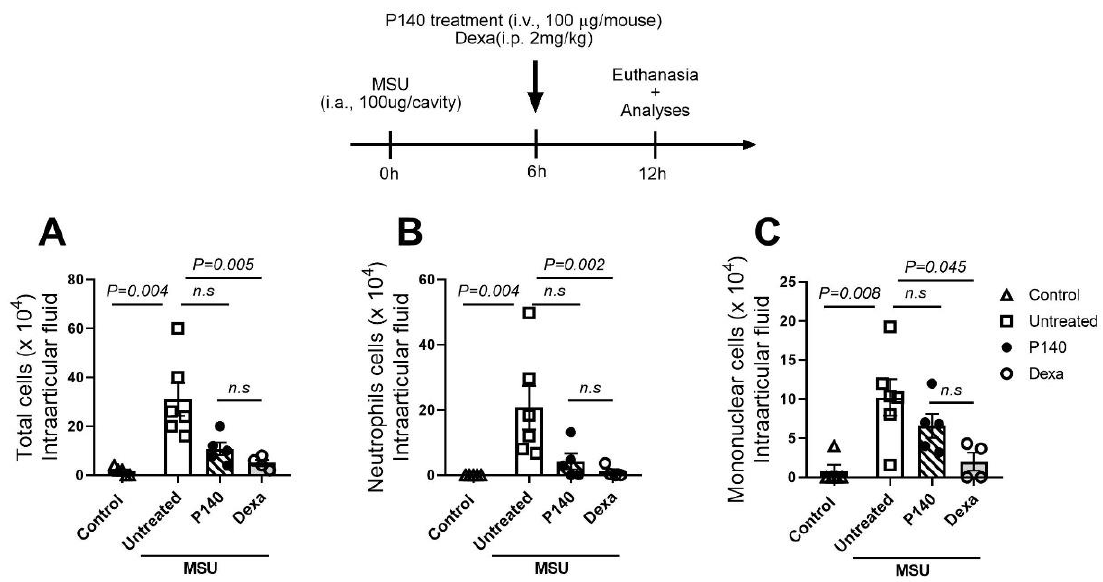
Figure 3. Effect of P140 peptide and dexamethasone on the number of neutrophils and mononu- clear cells in the intra-articular cavity of the knee of gouty mice . Mice were post-treated with P140 peptide (100 µ g/mouse; i.v.) or dexamethasone (2 mg/kg i.p.) 6 h after MSU injection. Cells were harvested from the i.a. cavity 15 h post-MSU induction. ( A ) The number of total cells, ( B ) neutrophils, and ( C ) mononuclear leukocytes were determined by Neubauer chamber and cytospin counting. Data are mean ± SEM of 5–6 mice per group, p values were calculated using Mann–Whitney or Kruskal–Wallis tests following Dunn’s post hoc test. n.s = non-statistical.